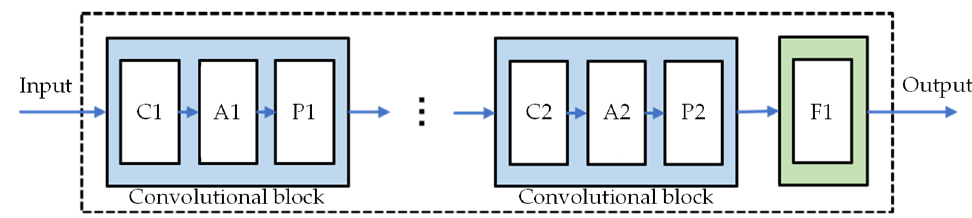
Figure 1. Typical architecture of CNNs.